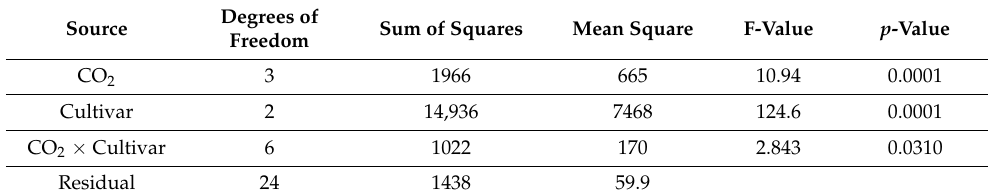
Table A3. Analysis of variance for area of third leaves of three bean cultivars grown at 29/17 ◦ C with four day/night CO 2 conditions.